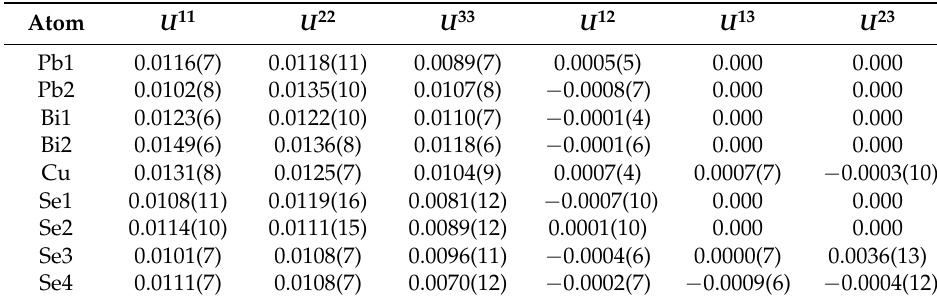
Table 7. Anisotropic displacement parameters ( U ) of the atoms for the selected cerromojonite crystal. Atom